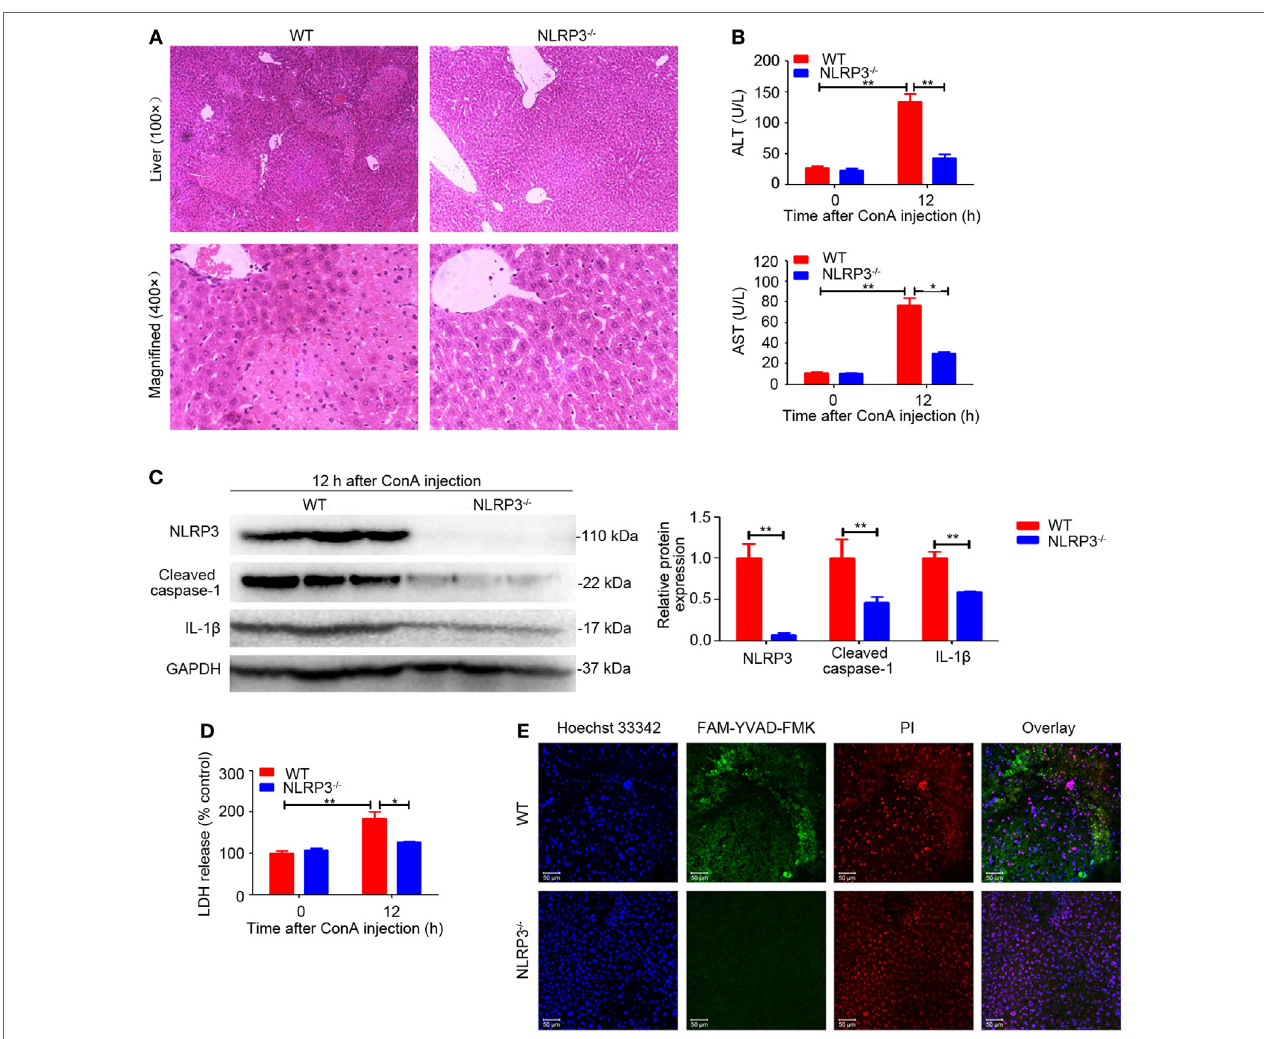
FigUre 2 | NOD-like receptor protein 3 (NLRP3) deficiency alleviated ConA-induced liver injury. (a) NLRP3 − / − mice and WT mice ( n = 6 for each group) were treated with ConA (20 mg/kg), and corresponding samples were isolated from mice at 0 and 12 h post ConA challenge. Hepatocellular damage was detected by hematoxylin and eosin (H&E) and representative images of liver tissues were shown (100 × , magnification: 400 × ). (B) Serum ALT and aspartate transaminase levels in WT and mice were detected. (c) The protein levels of NLRP3, cleaved caspase-1 and IL-1 β in the livers of mice with autoimmune hepatitis (AIH) were analyzed by western blot. GAPDH was used as a loading control. Each lane represented a separate animal. Results shown were obtained from three experiments. Quantification was presented in bar graphs. (D) Pyroptosis was detected by serum lactate dehydrogenase (LDH). (e) Representative fluorescence images of liver tissues co-stained with FAM-YVAD-FMK and propidium iodide (PI). FAM-YVAD-FMK (green), PI (red), Hoechst 33342 (blue). The data were presented as means ± SD (Student’s t -test, * p < 0.05, ** p <